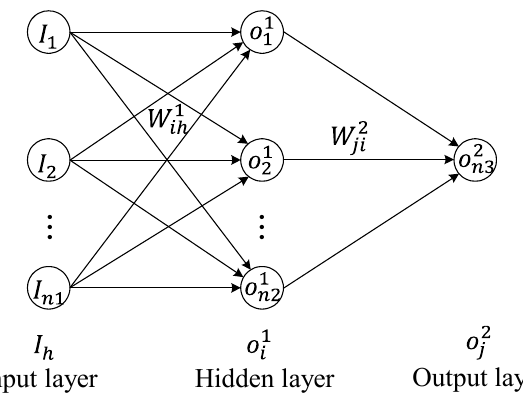
Figure 12. Structure of ANN [38].